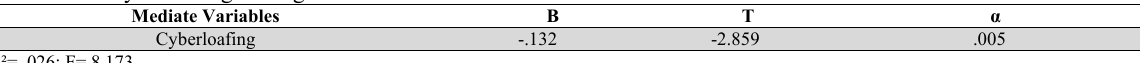
The Effect of Cyberloafing on Organizational